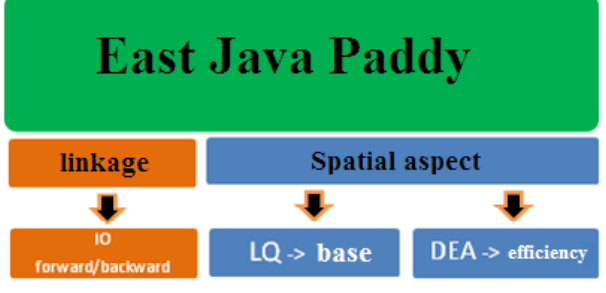
Figure 3: Conceptual